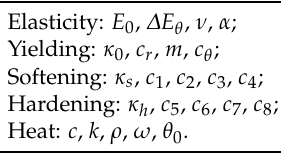
Table 1. Model parameters that need to be